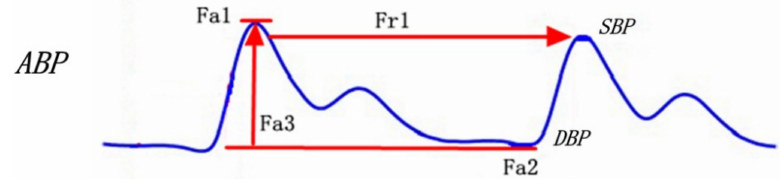
Figure A1. Diagrams of ABP and pulse derived features.